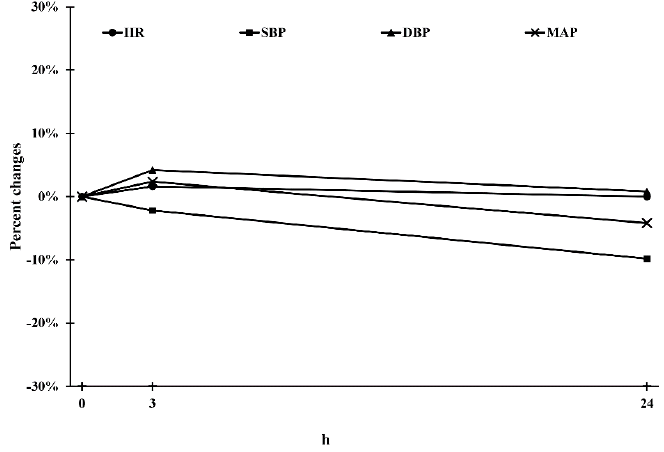
Figure 2. Physiology parameters during the observational period. HR: heart rate; SBP: systolic blood pressure; DBP: diastolic blood pressure; MAP: mean arterial pressure.